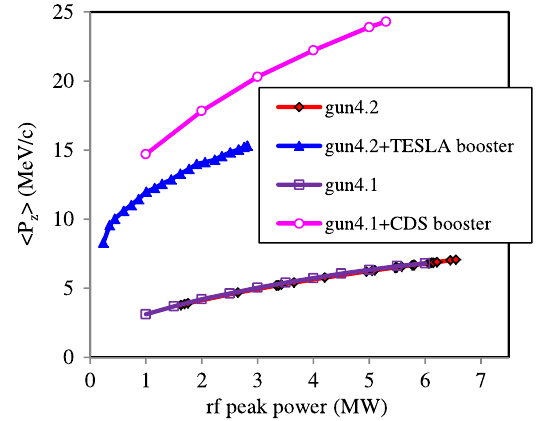
FIG. 4. Electron beam mean momentum as a function of the peak rf power in the gun and booster. For the momentum measurements after the booster the gun was operated at the maximum mean momentum